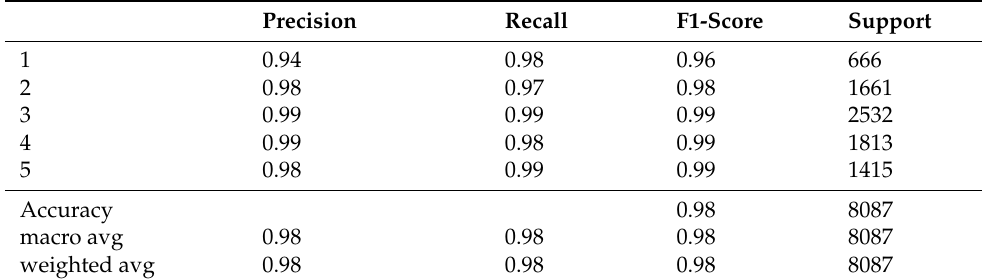
Table 9. Classification Report of the Stacking